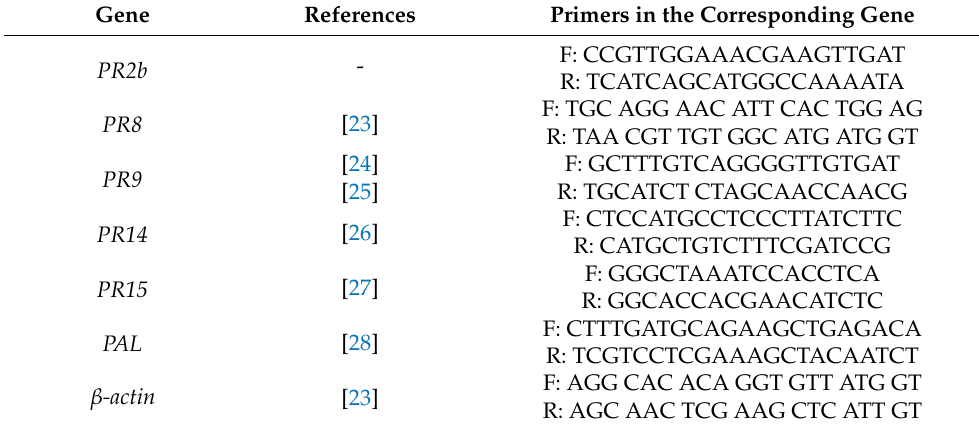
Table 1. List of primers used in real time q-PCR experiments on tomato plants ( Solanum lycopersicum ). F: Forward; R: